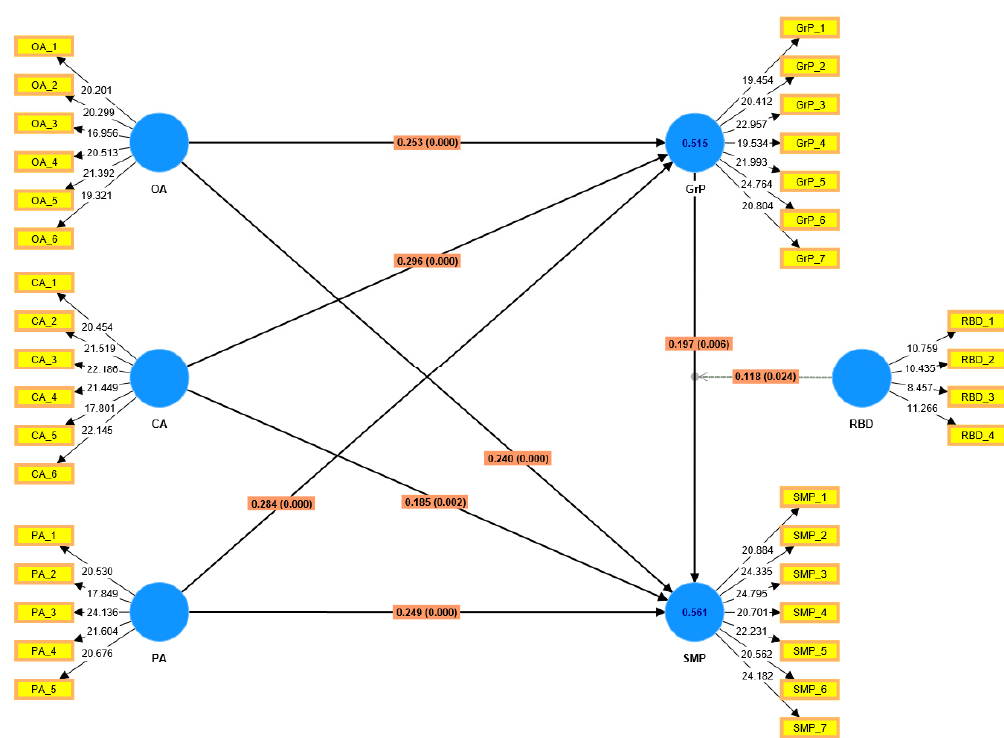
Figure 3. Structural Model.